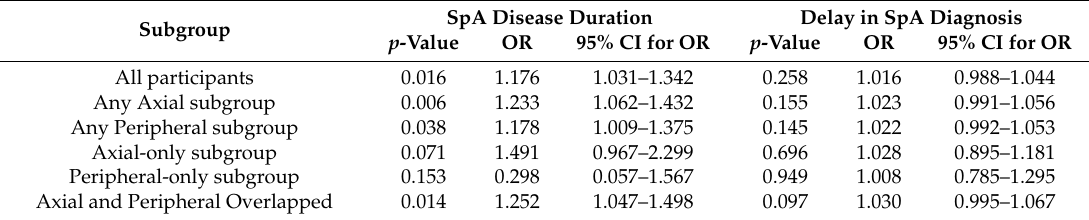
Table 3. Summary of association between risk of diverticulitis and either “SpA disease duration” or “Delay in SpA Diagnosis”, adjusted for all potential confounders.